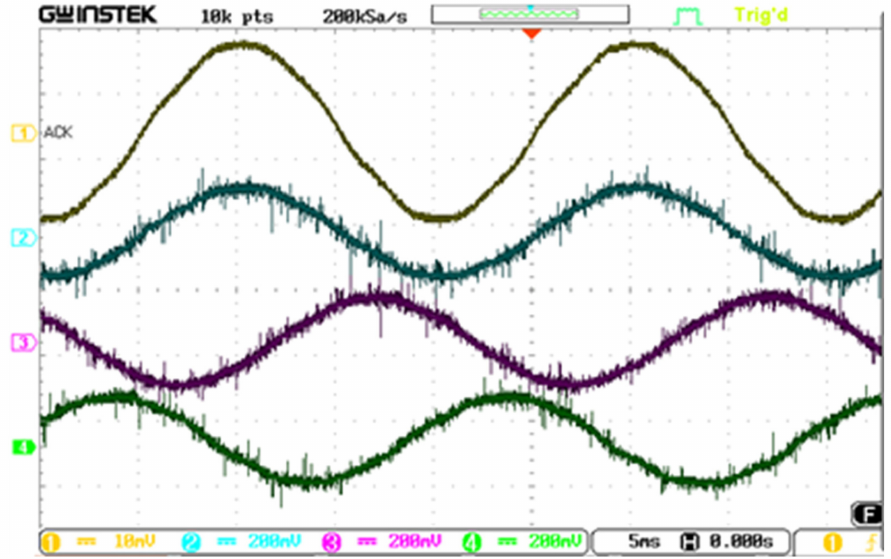
Figure 7. The outputs of the current transducers after applying a three-phase voltage to a three-phase resistance, (Cha-1) FLUKE current sensor on the first phase, (Cha-2, 3, 4) LEM current sensors to phase a, b, and c,